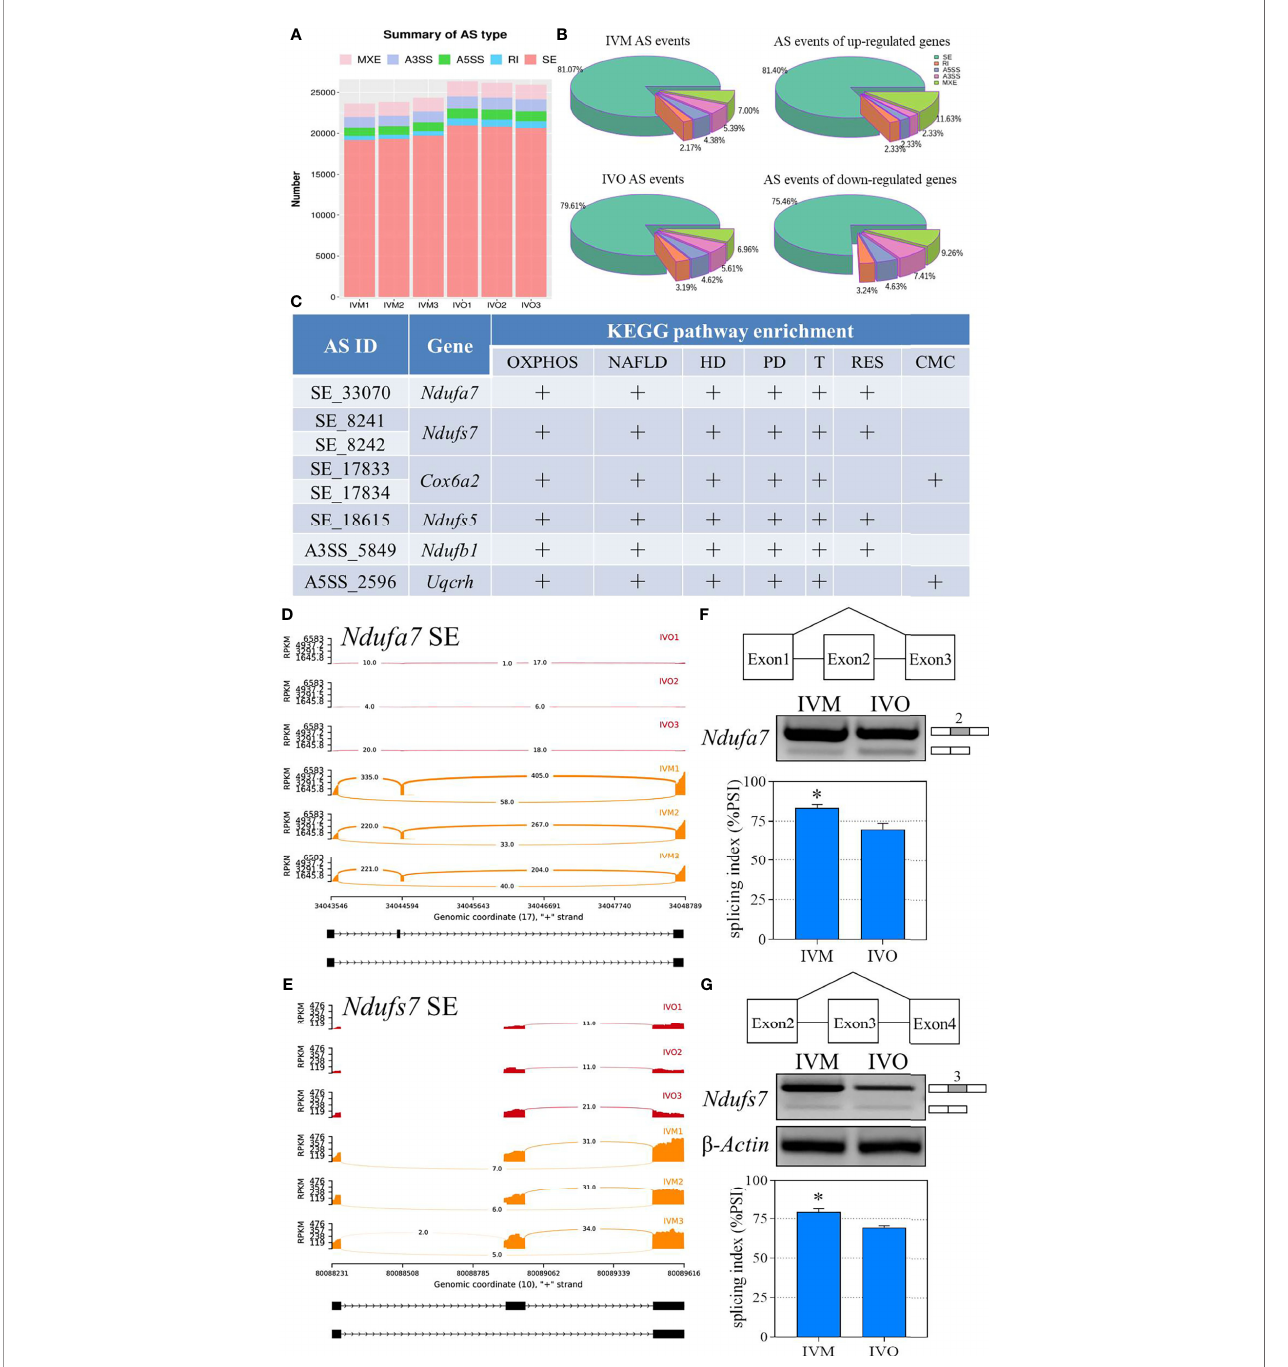
FIGURE 5 | Statistical analysis of the AS events for KEGG enrichment terms. (A) A comparison of the number of AS events between the IVO and IVM groups. (B) The proportion of AS events of the IVM group, IVO group, the up-regulated and down-regulated genes. (C) List of signi fi cantly different AS events for the top four KEGG enriched overlapping DEGs (OXPHOS, oxidative phosphorylation; NAFLD, non-alcoholic fatty liver disease; HD, Huntington disease; PD, Parkinson disease; T, Thermogenesis; RES, retrograde endocannabinoid signaling; CMC, cardiac muscle contraction. Sashimi plots depicting the visualize speci fi c splice sites of splicing events for exon skipping of the Ndufa7 (D) and Ndufs7 (E) genes. The red plots represent the IVO group while the orange plots represent the IVM group. The distribution of the number of junction reads is shown for each sample. The schematic in the upper panels represent the different splicing pattern. Representative agarose gels of semi-quantitative RT-PCR for Ndufa7 exon 2 (F) and Ndufs7 exon 3 (G) are shown in the middle panels. b - Actin served as an internal control. The histogram in the lower panel shows the average PSI that the IVO oocytes present exon inclusion suppressed compared with the IVM oocytes. Data represent the mean ± SEM of three independent experiments. * P <